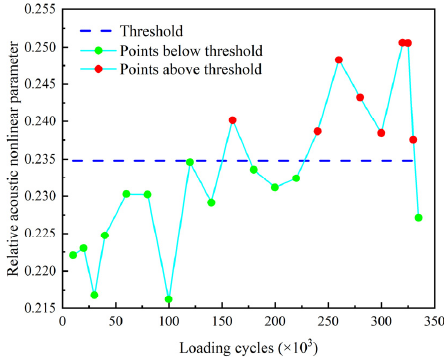
(cid:48) re versus loading cycles.